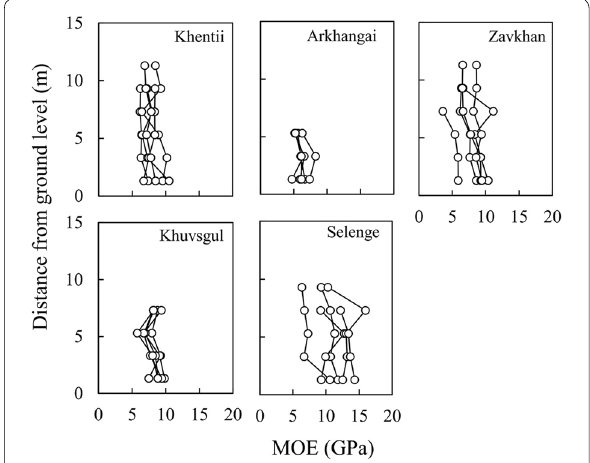
Fig. 1 Longitudinal variations of modulus of elasticity (MOE) of lumber in each provenance. Open circles indicate mean values of MOE of lumber obtained from each height. n number of